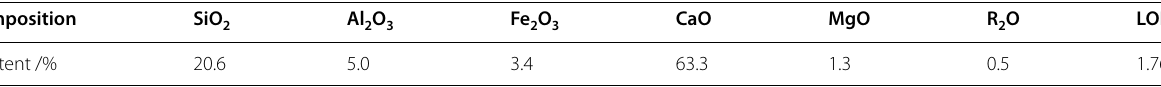
Table 1 Chemical composition of Portland cement.